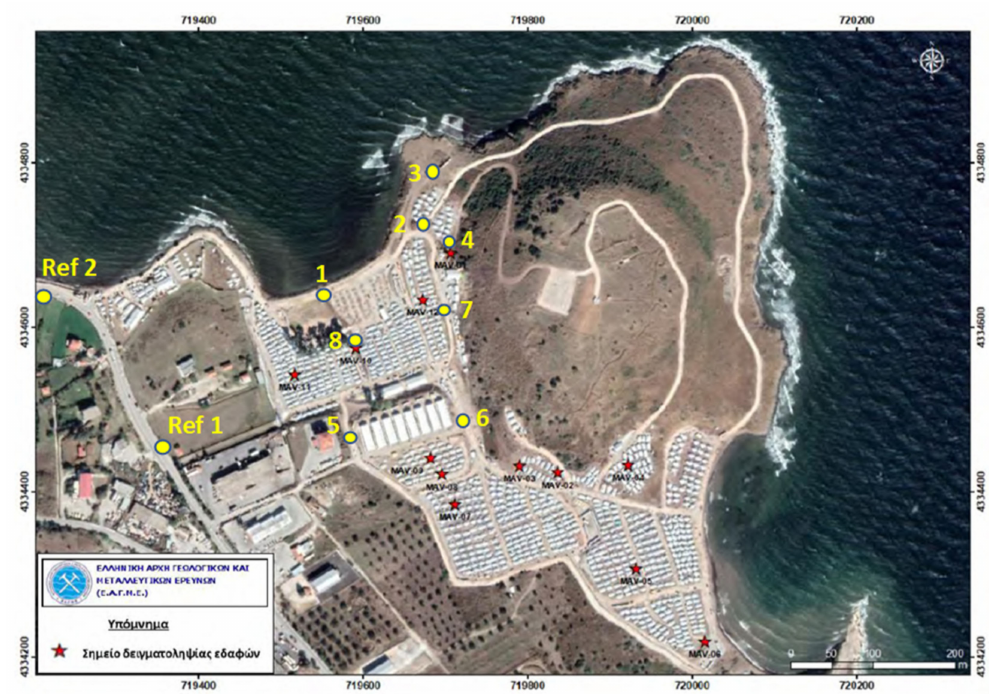
Figure 1. Aerial photo of the Mavrovouni camp. Yellow dots show the location of the eight sampling sites within Mavrovouni and the location for the two reference samples included in the present work. Red stars show sampling sites in the EAGME study. The small white rectangles are tents and related structures in the refugee camp where families reside. Image from EAGME